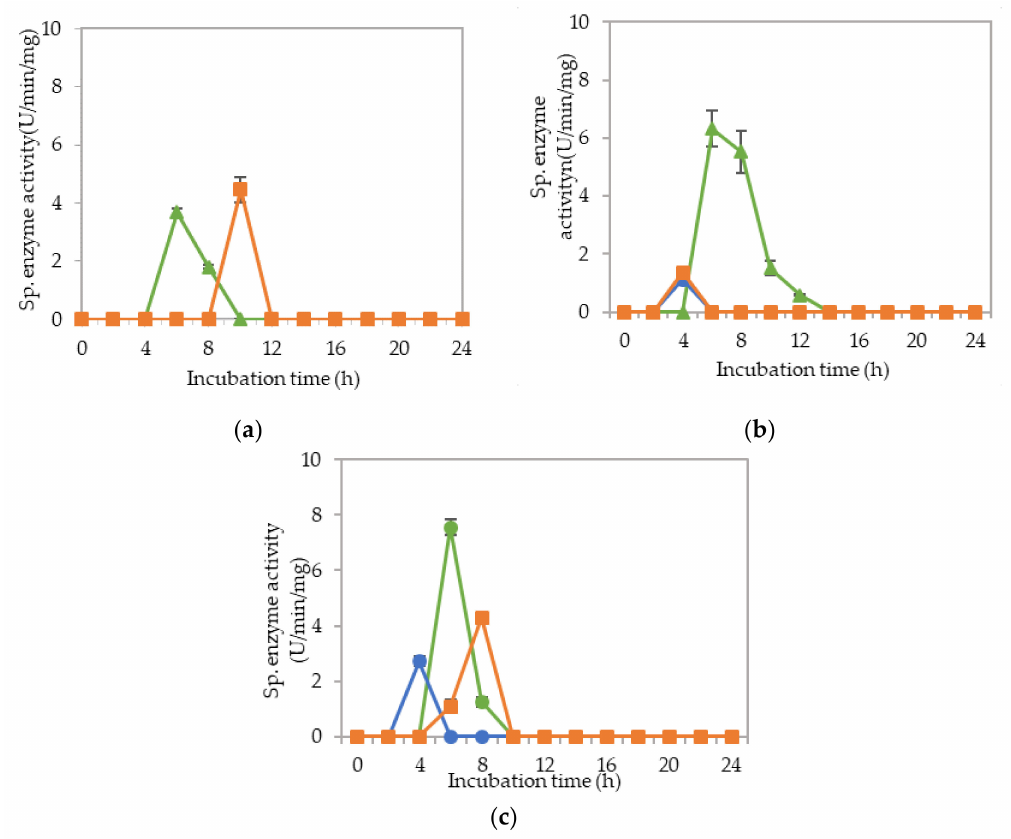
Figure 7. The specific extracellular cellulolytic and hemicellulolytic activities; ( • ) endoglucanase; ( (cid:4) ) exoglucanase; ( (cid:78) ) β -glucosidase and ( (cid:7) ) mannanase of Lactobacillus plantarum RI 11 grown in M5 (PKC and yeast extract) for 24 h. The enzyme activities were detected at three di ff erent pH levels: ( a ) pH 5; ( b ) pH 6.5; ( c ) pH 8. The error bars represent the standard deviation of specific enzyme activity of triplicate samples ( n =